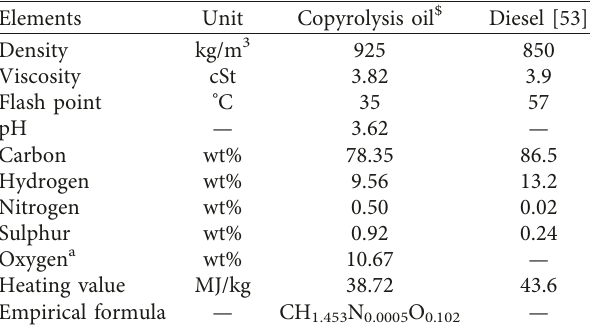
Figure 3: Experimental and theoretical product yields during copyrolysis performed at 500 ° C. Table 2: Properties of copyrolysis oil.